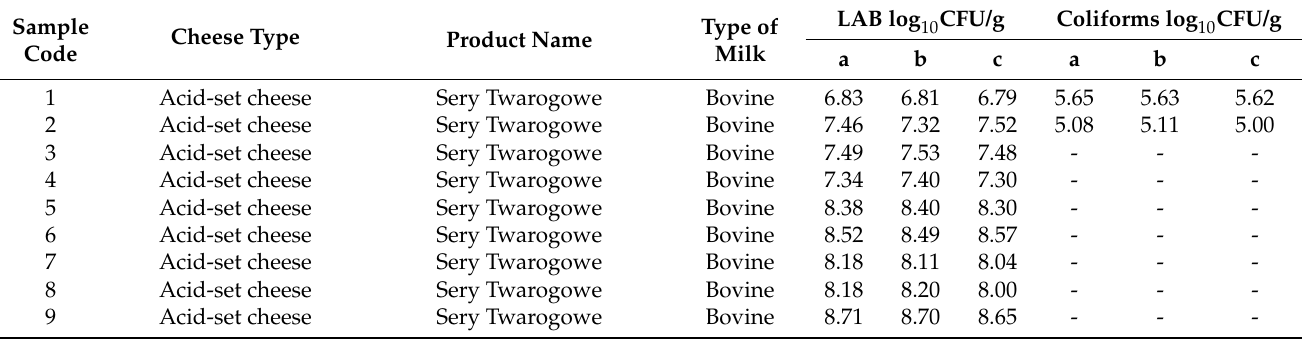
Table A1. Raw data of the microbiological concentrations of lactic acid bacteria (LAB) and coliforms of the sampled Polish farm, raw milk